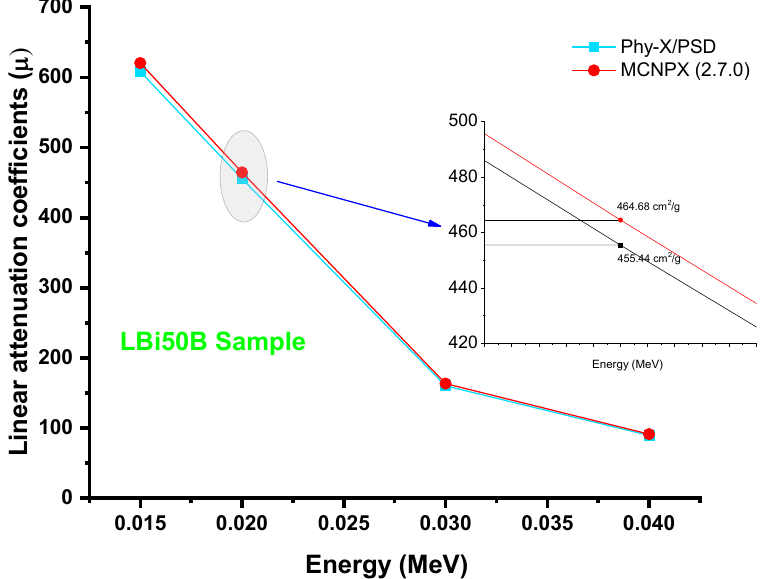
Figure 12. Comparison of obtained linear attenuation coefficients from MCNPX Monte Carlo code and Phy-X/PSD.